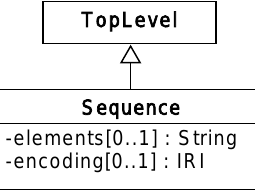
Figure 7: Diagram of the Sequence class and its associated